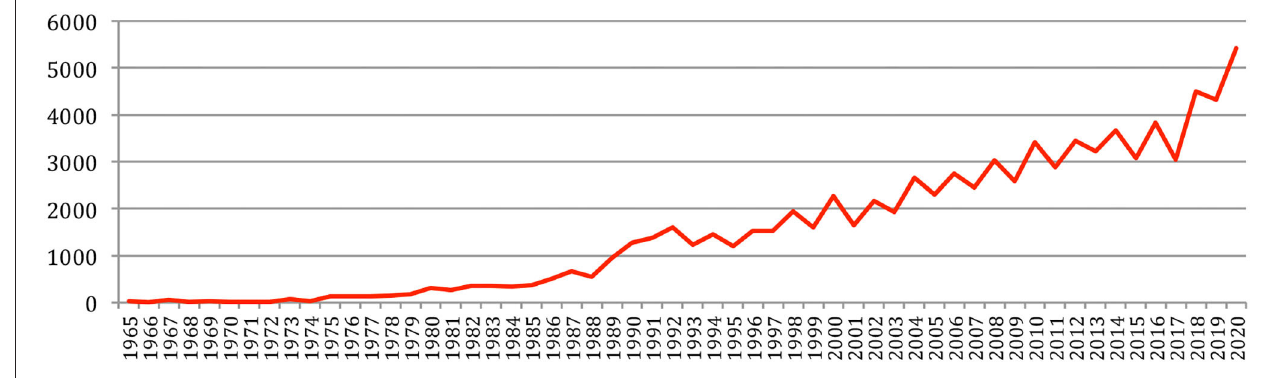
FIGURE 1 | Number of papers each year.